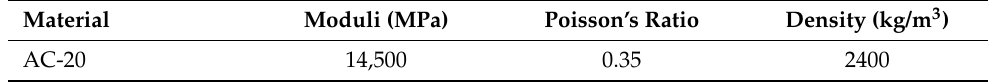
Table 3. Elastic material properties